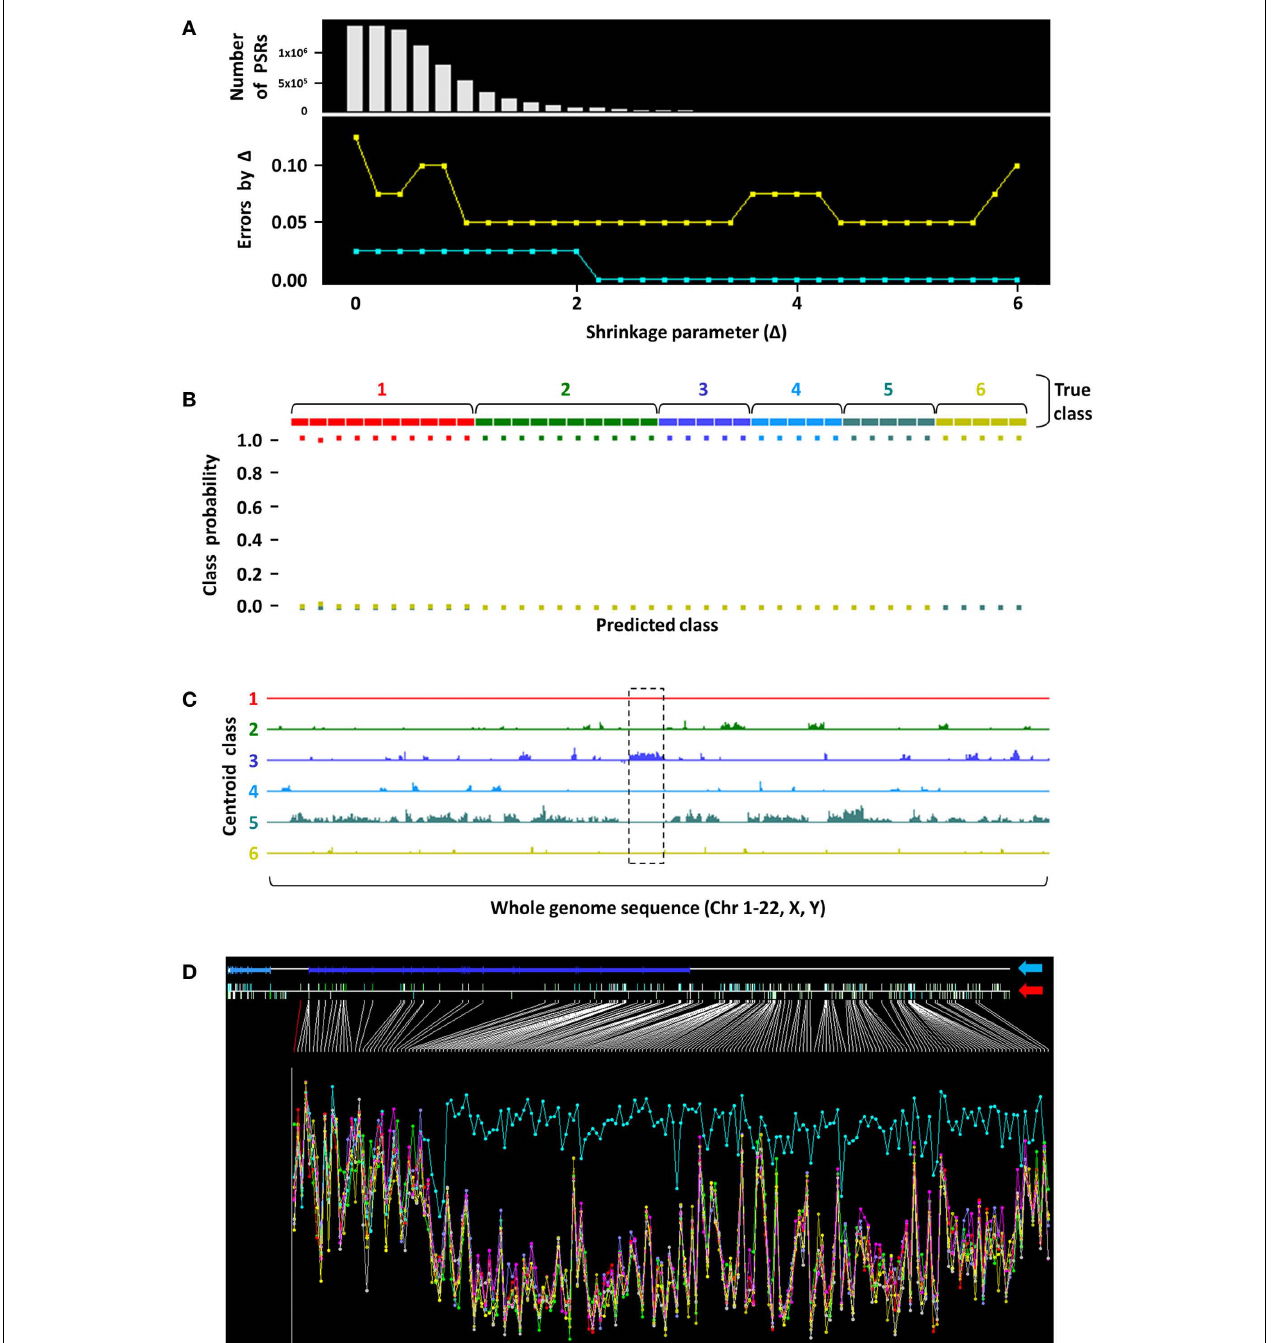
of the like color are found at the 100% probability level in each true class. (C) Whole-genome plot of positions of the diagnostic PSRs ( X -axis) that characterize the respective tumor groups versus their expression levels ( Y -axis). A 250-kb stretch corresponding to a putative vlncRNA region (dashed black box) was observed as being uniquely overexpressed in EFT. (D) When zoomed in at this genomic segment (blue arrow points to the RefSeq annotation; red arrow indicates positions of PSRs across the region), evidence of significant overexpression of this transcript in EFTs (aqua trace) was clear compared to other childhood tumor types. Height of the Y -axis corresponds to the logarithm of PSR expression levels, and samples are aggregated into their respective tumor